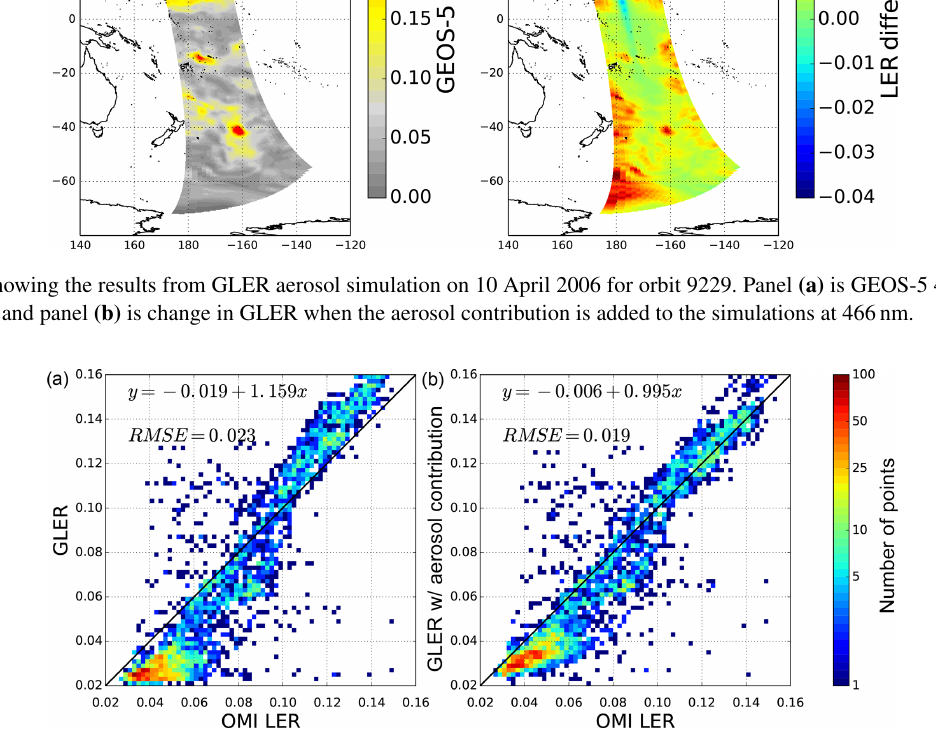
Figure 6. Comparison of GLER versus OMI-derived LER for orbits on 10 April 2006 over the Pacific Ocean. Panel (a) is GLER compared to the OMI-derived LER at 466nm, whereas panel (b) is GLER with contribution from aerosols vs. OMI-derived LER for 466nm. All data are filtered to remove clouds with the Raman-based